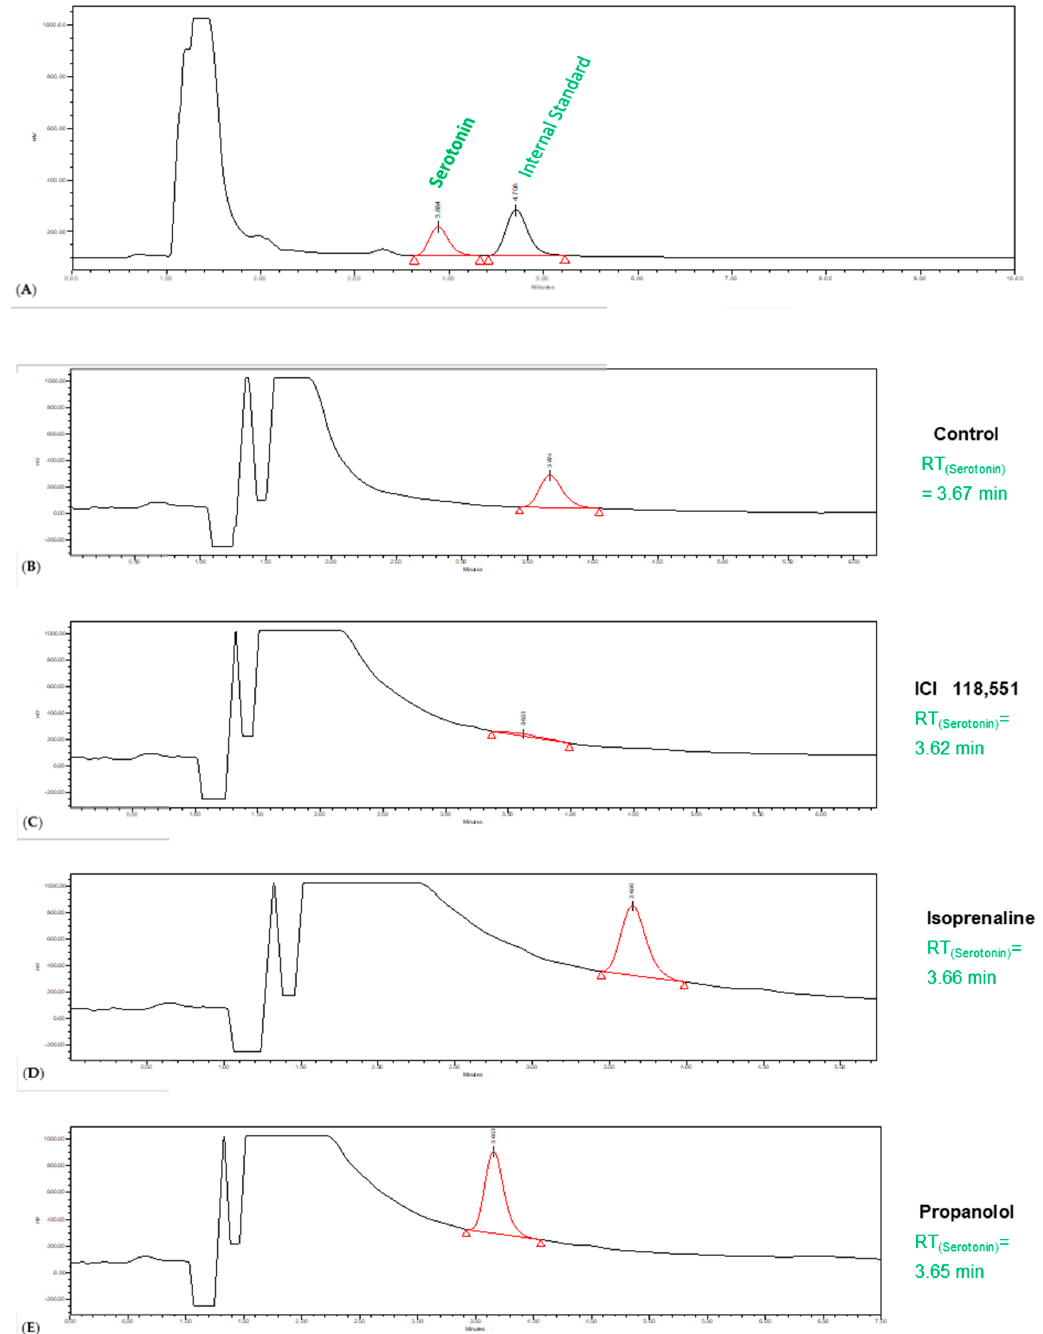
Figure 9. Analysis of 5-HT by HPLC-ECD. Representative chromatograms of ( A ) internal standard containing the indicated monoamine, ( B ) cell culture medium sample of untreated cells (control), ( C ) cell culture medium sample of ICI 118,551 treated cells, ( D ) cell culture medium sample of isoprenaline treated cells, and ( E ) cell culture medium sample of propranolol treated cells. Representative chromatograms were obtained in three independent experiments ( n =